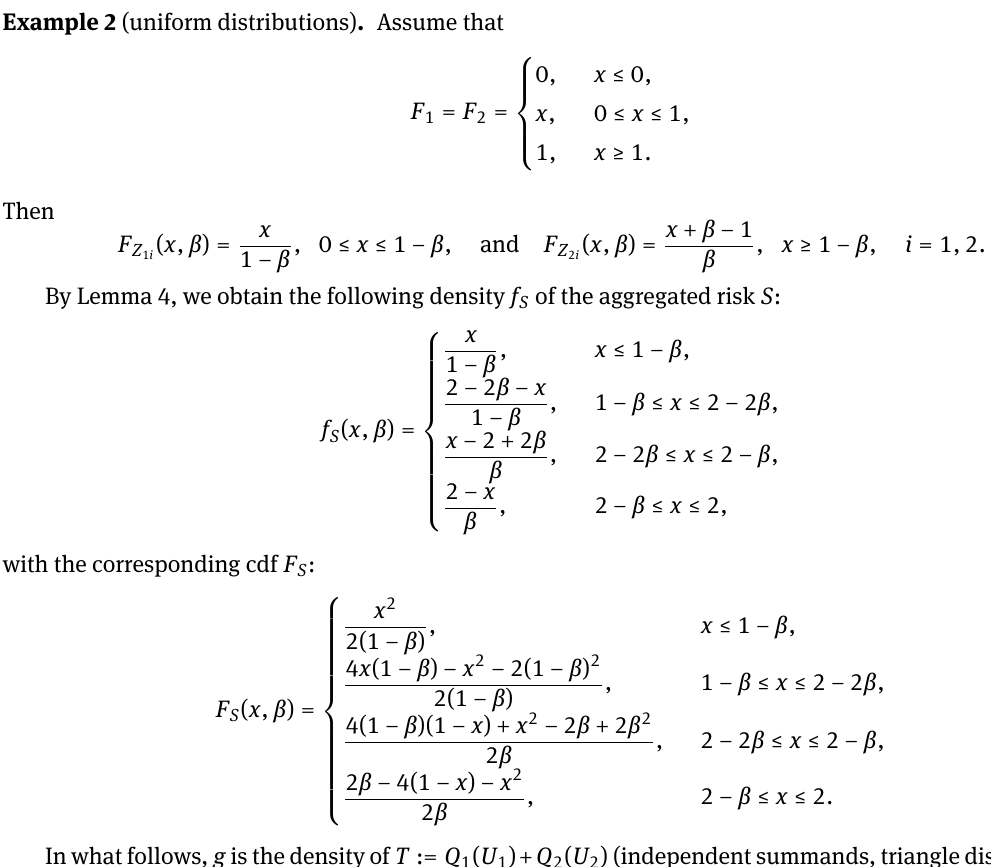
(0.995, β ) in Example S